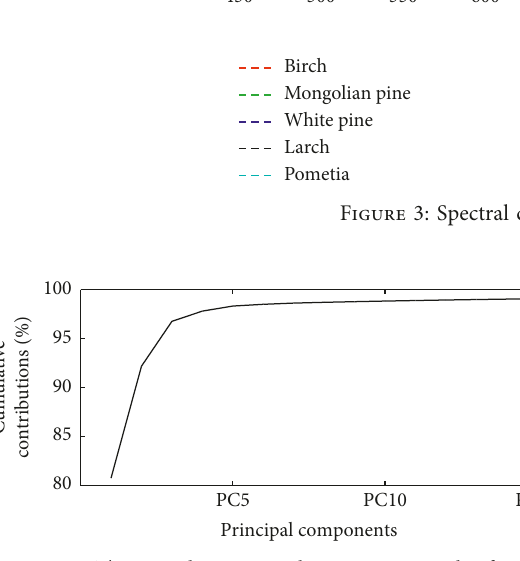
Figure 4: The cumulative contribution ratio graph of PCA.